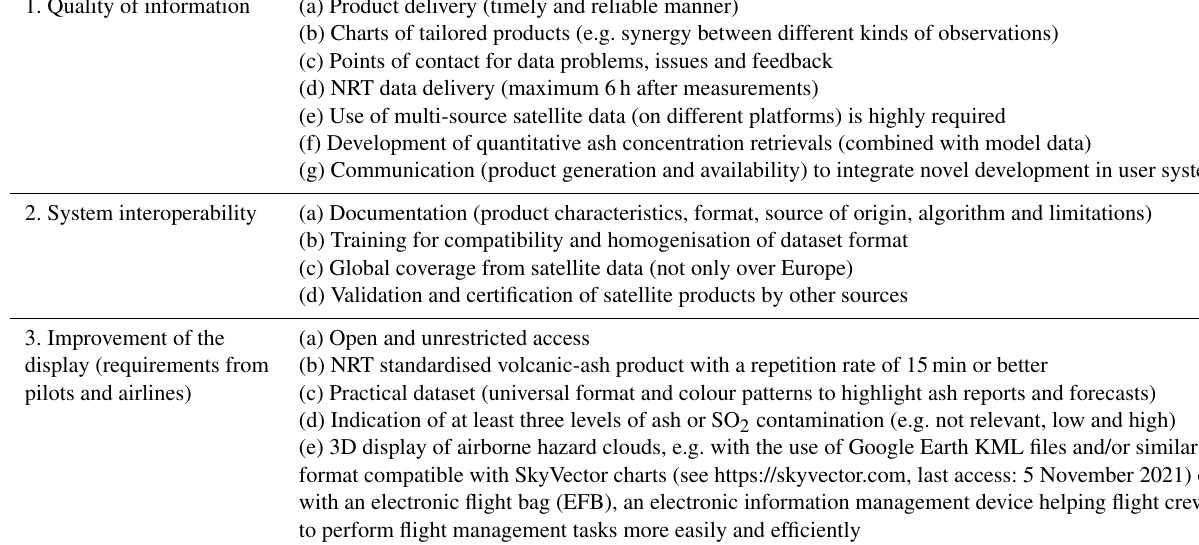
Table 4. Overview of user requirements from external sources. KML: Keyhole Markup